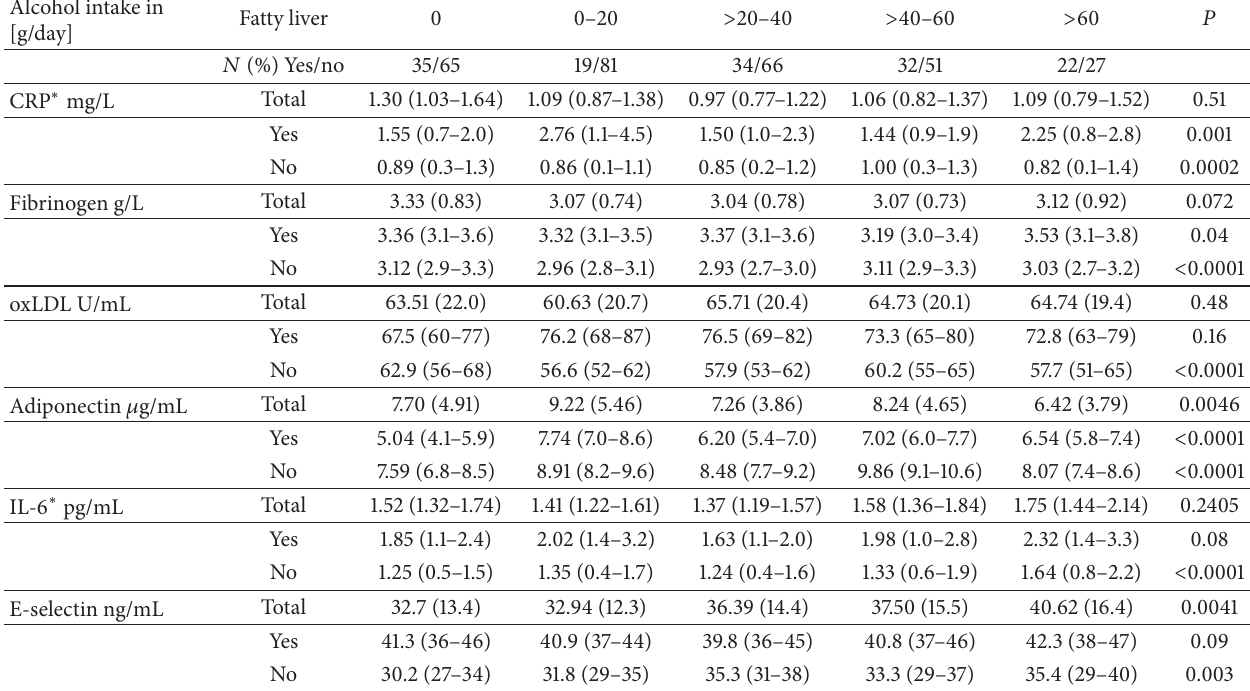
Table 3: Concentrations of inflammatory markers, according to alcohol consumption (arithmetic or geometric ∗ mean with 95% confidence intervals, 𝑃 for difference between